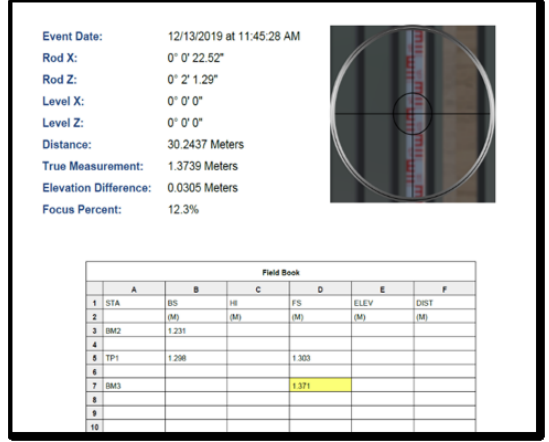
Figure 7. Screenshot of output PDF used for instructional